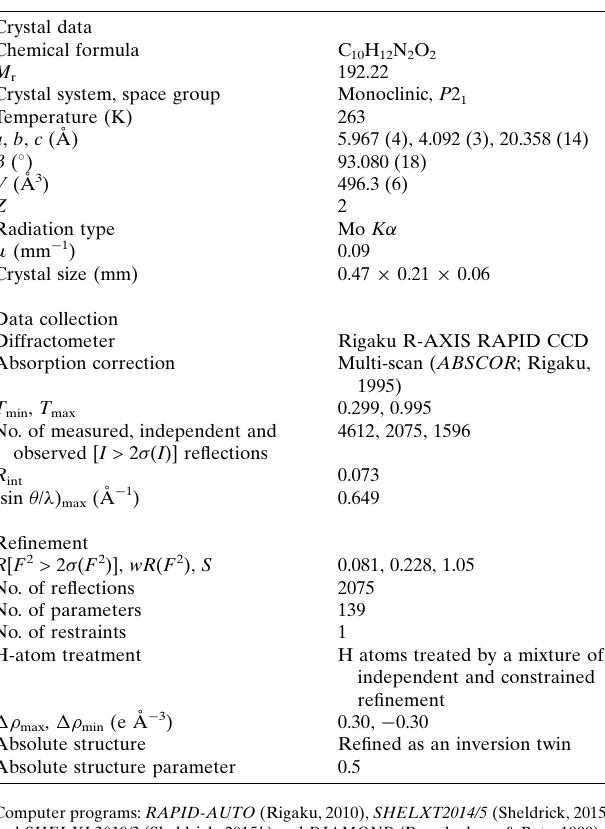
Table 1 Hydrogen-bond geometry (A˚ , (cid:5) ).